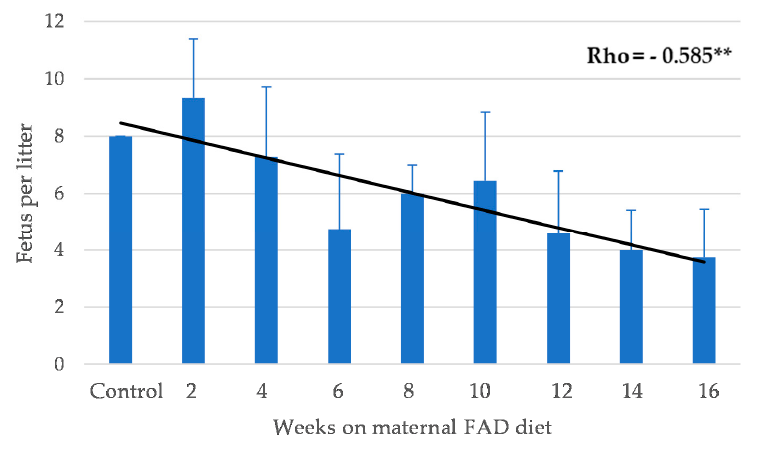
Figure 2. Mean number of fetuses per litter according to weeks on maternal folic acid deficient (FAD) diet. ** p ≤ 0.01 (Spearman’s rho test).